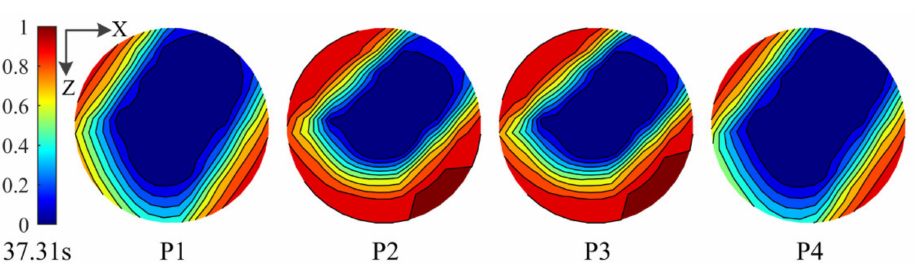
Figure 16. The compression damage of concrete in the core area at 37.31 s.